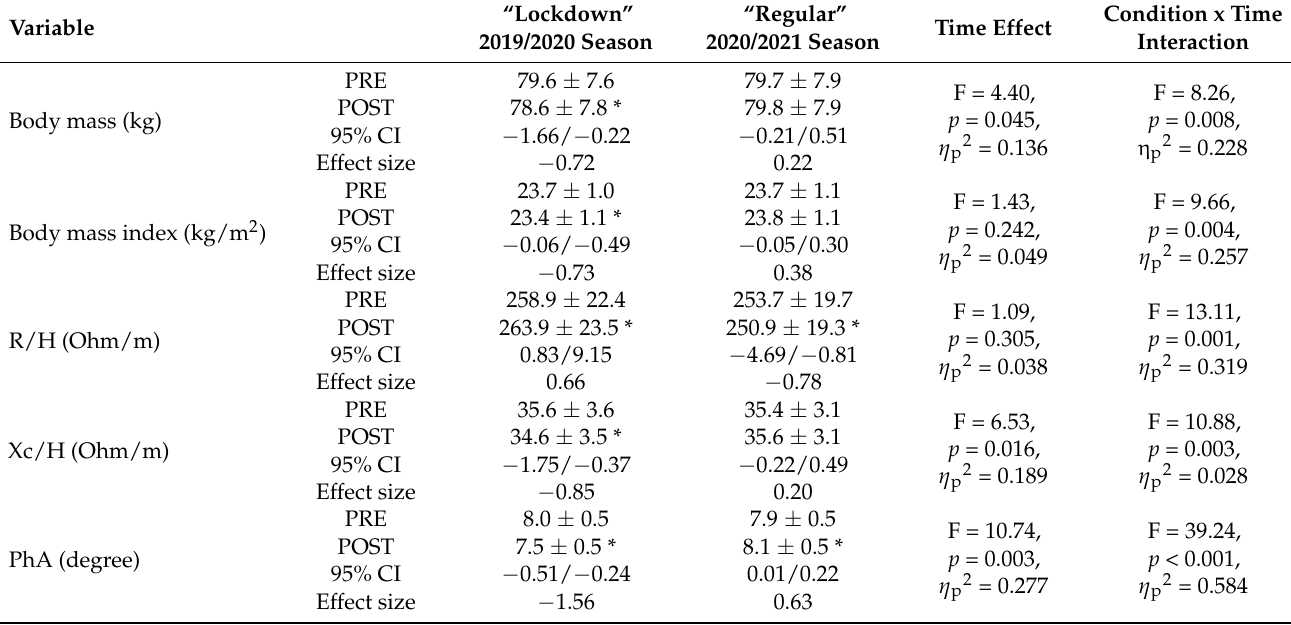
Table 2. Baseline (PRE) and post values (mean ± standard deviation) of dependent parameters are shown. Differences over time are reported as mean with 95% confidence interval (CI). Effect size is also reported.